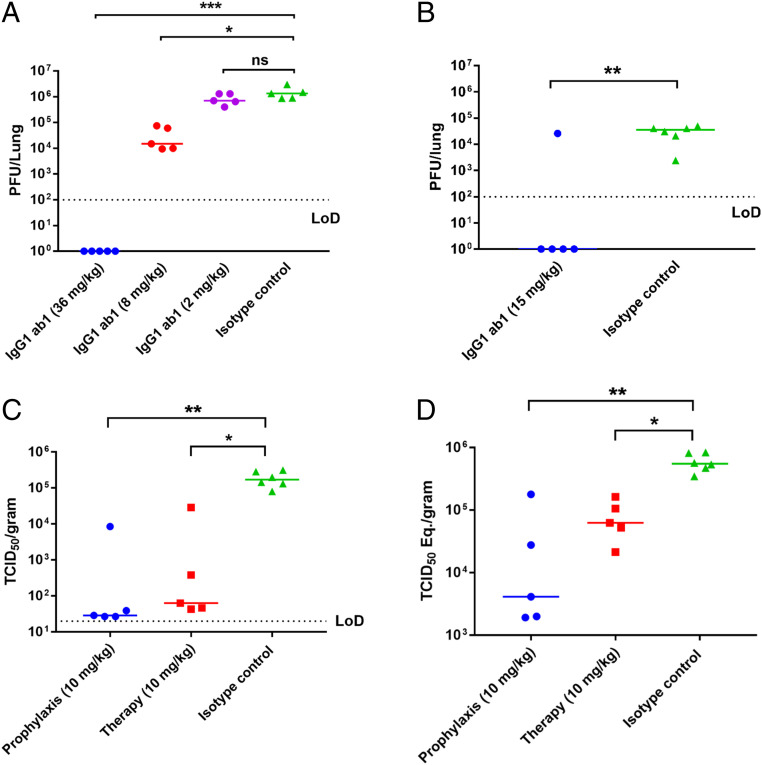
IgG1 ab1 potently neutralizes SARS-CoV-2 in three animal models. (A) IgG1 ab1 inhibits mouse ACE2-adapted SARS-CoV-2 in wild-type BALB/c mice. Mice were treated i.p. with varying doses of IgG1 ab1 or an isotype control 12 h prior to intranasal infection with 105 pfu of mouse-adapted SARS-CoV-2. Lung tissue was homogenized in PBS and virus replication assessed by plaque assay using VeroE6 cells (Kruskal–Wallis test followed by Dunn’s test, ns: P > 0.05, *P < 0.05, ***P < 0.001). (B) IgG1 ab1 protects hACE2 transgenic mice from SARS-CoV-2 infection. The experimental protocol is similar to the one above except that human ACE2 transgenic mice and wild type SARS-CoV-2 were used (Mann–Whitney U test, *P < 0.05). (C and D) Evaluation of prophylactic and therapeutic efficacy of IgG1 ab1 in a hamster model of SARS-CoV-2 infection. IgG1 ab1 significantly reduced the lung viral titers (C) and viral RNA presented as TCID50 equivalents (D). Hamsters were injected intraperitoneally with 10 mg/kg of IgG1 ab1 antibody either 1 d before (prophylaxis) or 6 h after (therapy) intranasal challenge of 1 × 105 TCID50 of SARS-CoV-2. At the time of killing (5 dpi), lungs were collected for virus titration by viral TCID50 assays and viral RNA quantification by RT-qPCR (Kruskal–Wallis test followed by Dunn’s test, *P < 0.05, **P < 0.01).